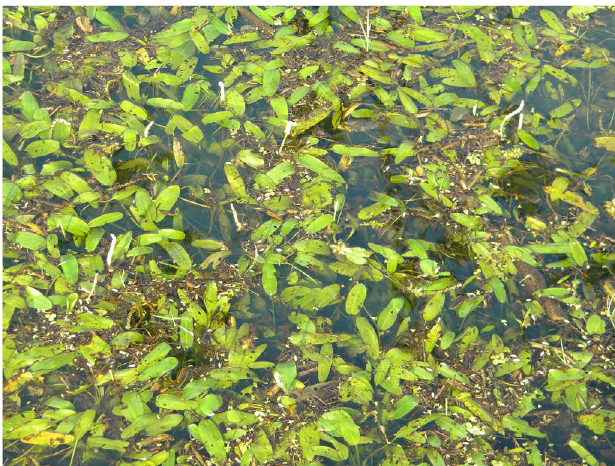
Figure 4. Aponogeton natans , an edible tuber yielding hydrophyte establishing life on low-depth